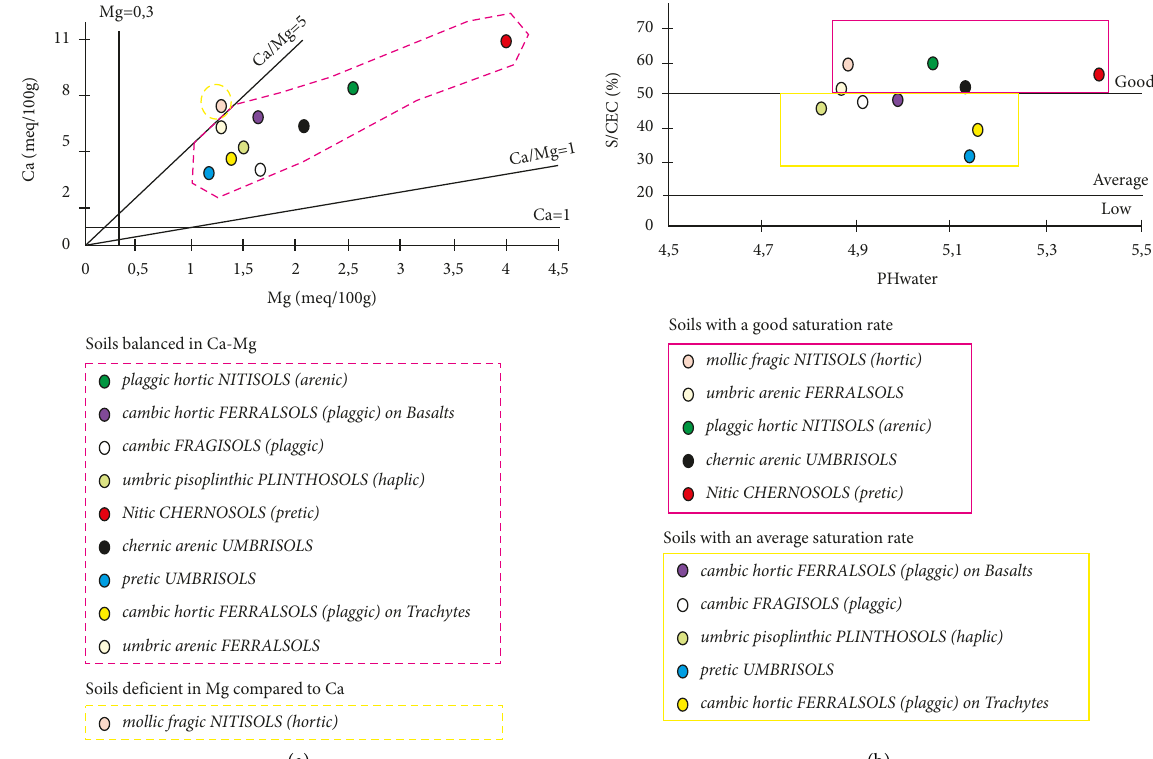
Figure 7: Nutritional balance of Foumban soils in Ca and Mg and saturation rate and pH. (a) Ca-Mg balance according to Martin [33] and (b) S/CEC-pH